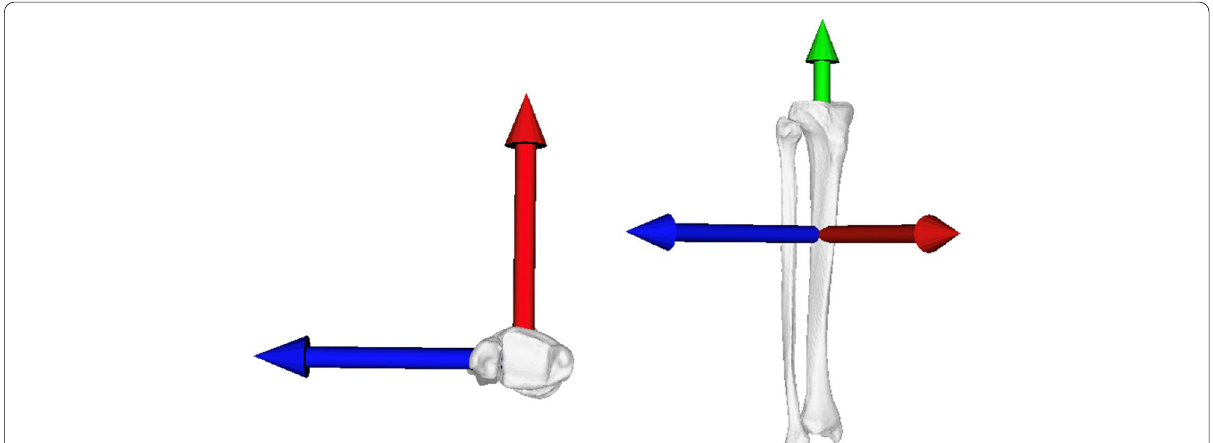
Fig. 1 Definition of the anatomical coordinate system. The origin was located in the geometric center of the tibia, the X‑axis (red) points from posterior to anterior, the Y‑axis (green) points from distal to proximal, and the Z‑axis (blue) points from medial to lateral